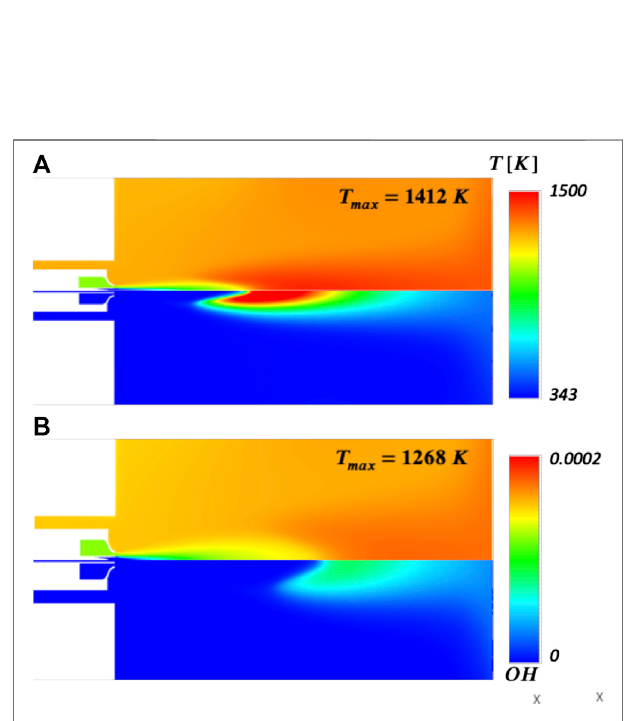
FIGURE 11 | Averaged axial and radial (z (cid:1) 100 mm) temperature pro fi les for 75% H 2 . Axial pro fi le shown as function of z+. Averaged experimental uncertainty of 10K.